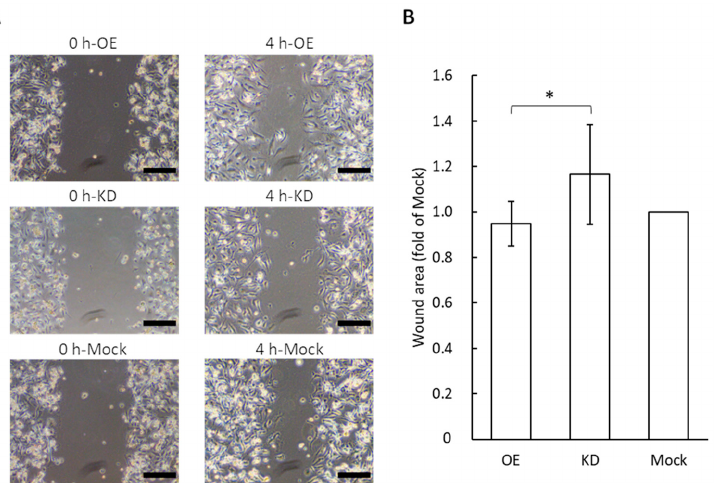
Figure 5. Wound healing assay for vascular endothelial cells by the application of exosomes containing different concentrations of GRP78. ( A ) Typical photos 4 h after wound healing assays for HUEhT cells after application of exosomes; scale bar = 250 μ m. ( B ) Comparison of wound area. The wound area is small, indicating that the cell motility is high; n = 9 each; * p < 0.05.